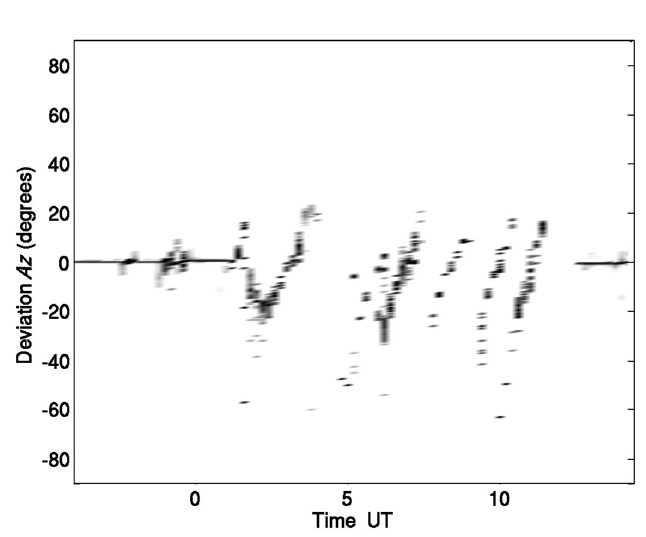
Fig. 14.7. Time history of the direction of arrival (azimuth only) of a 9.3 MHz signal propagating through a model ionosphere containing patches of enhanced electron density for By